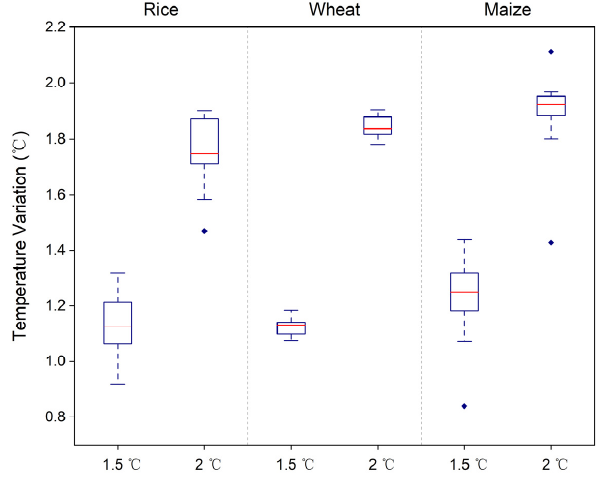
Figure 8. Growing season temperature variations in main crop-producing provinces at 1.5 °C and 2 °C global warming under SSP5-8.5 compared to the reference period (1995–2014).